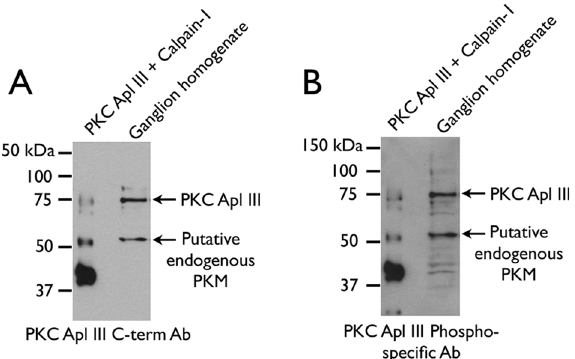
Fig 10. Characterization of endogenous PKM in homogenates. Antibodiesagainstthe PKC Apl III C- terminus (A) and B) PDK phosphorylation site (B) were used to probe membranes containing ganglion homogenate. For comparison, the neighboring lane containspurifiedPKC Apl III that has been incubatedwith mammalian CAPN-1 to induce cleavage.